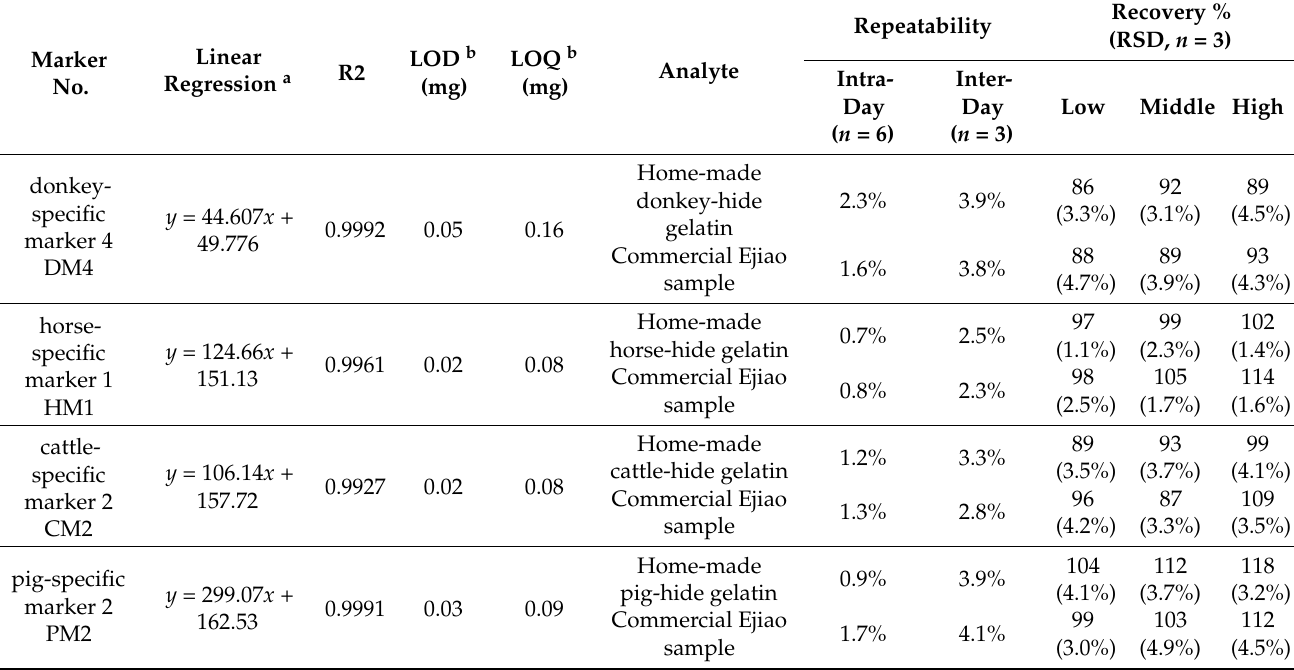
Table 5. Validation of the established quantitative method using four individual species-specific markers (DM4, HM1, CM2, and